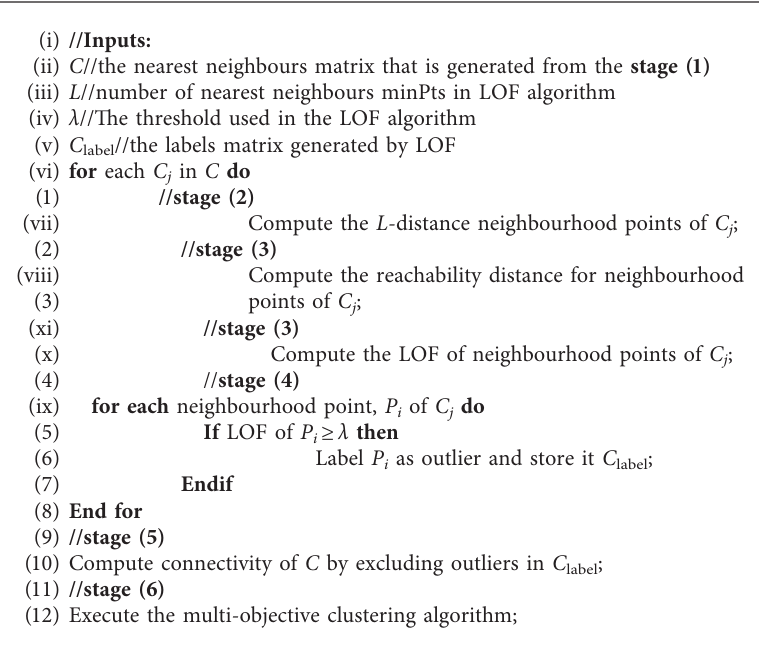
Table 2: The real-life and synthetic datasets used in the experiments of the proposed algorithm. Real-life